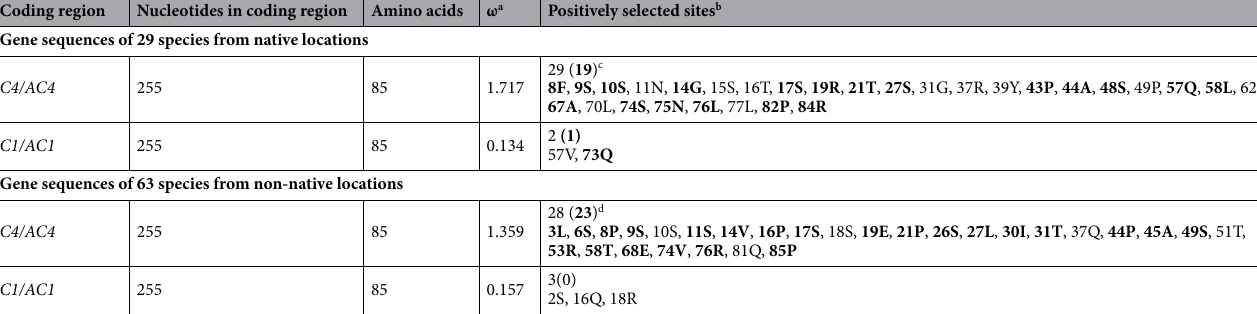
native range of tomato and areas where it was likely spread by indigenous people. Ninety-two of the 112 species (29 of the 34 native and 63 of the 78 exotic) had C4(AC4) genes with a N-terminal myristoylation motif and a length of 85–100 amino acids. If begomovirus isolates travelled with tomato plants or seed when they were moved from the New World, we might expect to see evidence of purifying selection in C4(AC4) if a host-specific interac- tion would be essential for begomoviruses on tomato outside of its native range ( e.g. no reservoir of congeners for viruses to move from onto tomato). C4(AC4) gene sequences from begomovirus isolates from tomato in native (29 begomoviruses) and exotic (63 begomoviruses) locations (Supplementary Table S4) were under strong positive selection with ω-values of 1.717 and 1.359, respectively, for the initial 255 nucleotides representing 85 amino acids (Table 3). Likelihood ratio tests (LRT) applied to the three pairs of models in CODEML indicated that ω varied across codons (M0 vs. M3) and that C4(AC4) was under positive selection (M2a vs. M1a and M8 vs. M7) (Supplementary Table S5). The codons under positive selection were located throughout the length of the C4(AC4) reference sequence, suggesting changes across the entire gene sequence may generate protein diversity. As expected, the C1(AC1) sequences were under purifying selection (Table 3 and Supplementary S5). Therefore, there is no evidence of either purifying or neutral selection in C4(AC4) genes from tomato-associated isolates taken from native or exotic regions.